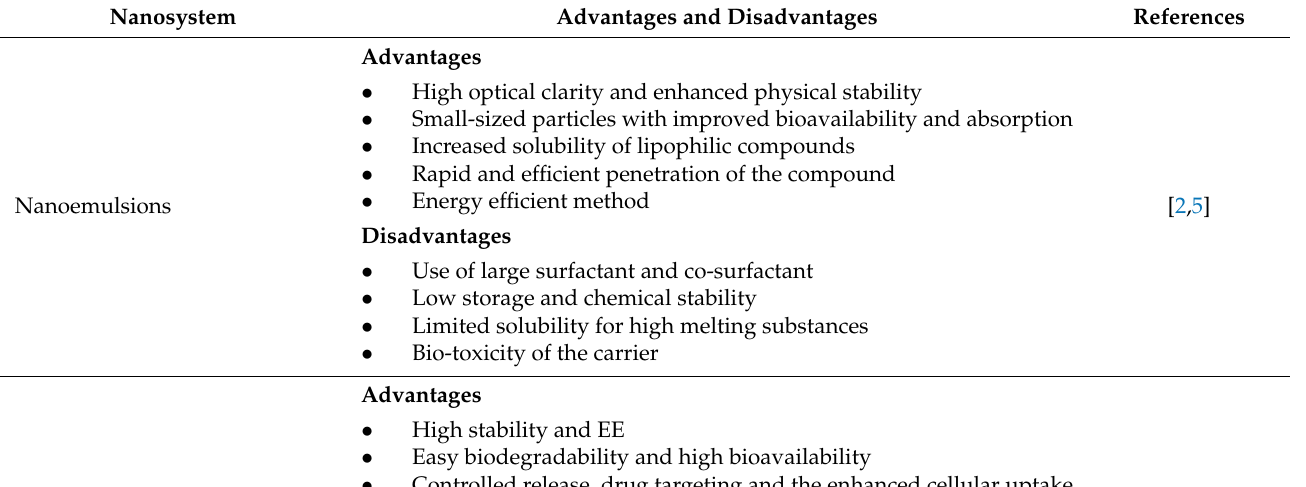
Table 2. The advantages and disadvantages of nanosystems for encapsulation of carotenoids 1 . Nanosystem Advantages and